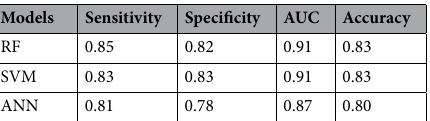
Table 1. Evaluation of machine learning models applied to the VEGFR-2 data.